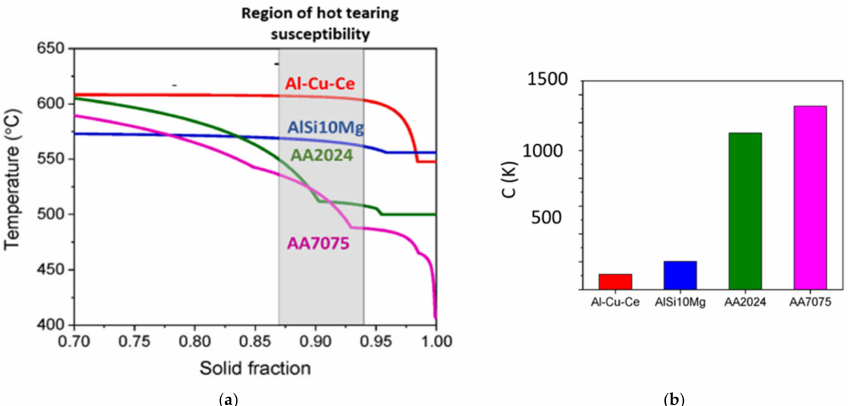
Figure 13. ( a ) Comparison of Scheil curves (at high solid fractions) of Al–Cu–Ce, AlSi10Mg, AA2024, and AA7075 alloys. The shaded region in ( a ) marks the range of solid fraction over which the hot-tearing susceptibility index C reported in ( b ) is calculated. Redrawn from ref. [186] (reproduced with permission from Additive Manufacturing; published by Elsevier,